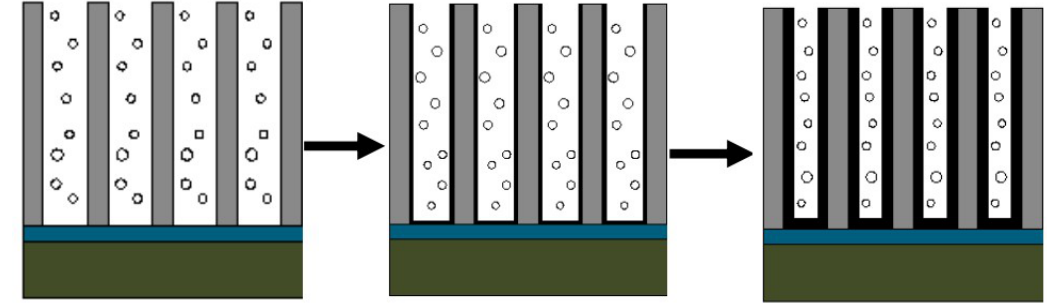
Figure 18. Schematic diagram of the mechanism for preparing carbon nanotube arrays through porous alumina membranes (PAM).